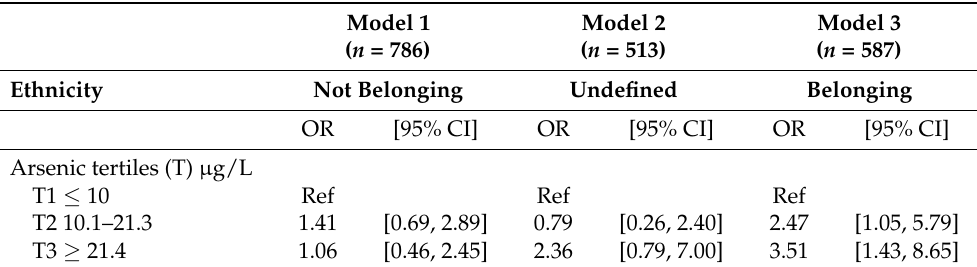
Table 4. Modifying effect of ethnicity on the association between urinary arsenic concentration and bronchial asthma in children, Arica (2009–2021). Model 1 ( n = 786) ( n =